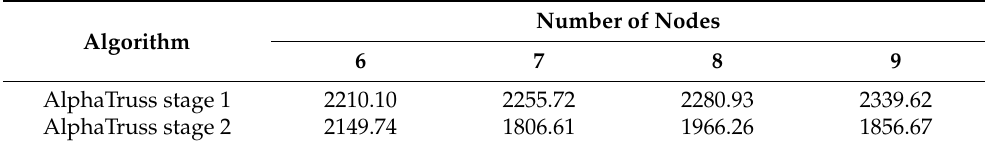
Table 12. Minimum weights (kg) for different number of